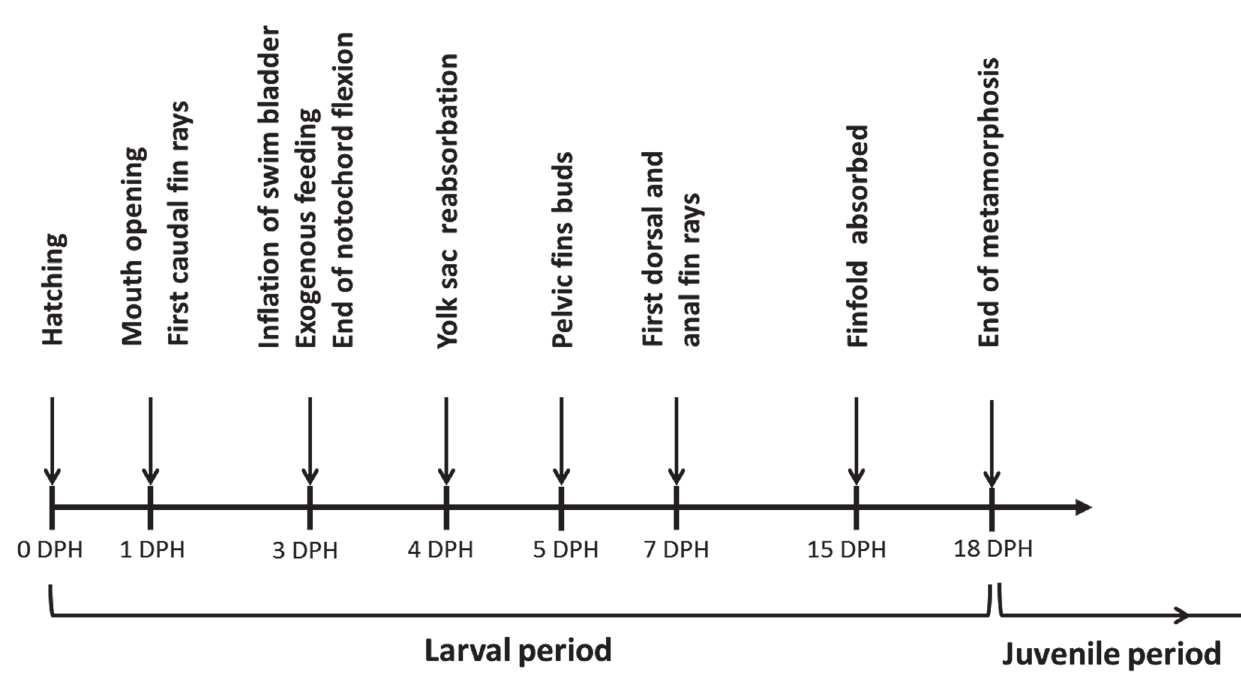
Fig. 3. Main events during larval development of the Nannacara annomala . DPH, days post